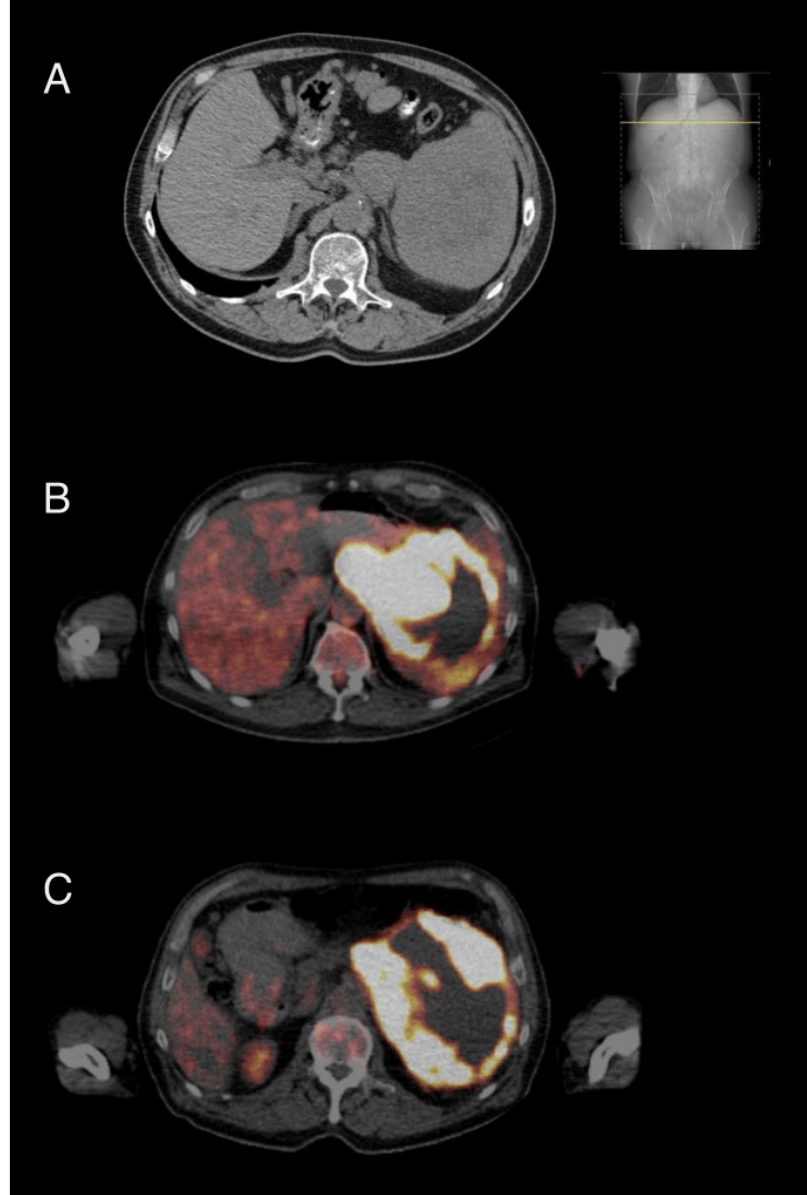
Figure 2. Clinical imaging of patient. ( A ) CT scan on 27 September 2017. Detection of DLBCL relapse with lymphoma manifestations around the splenic hilum. ( B ) PET-CT scan on 18 October 2017. Strong fluorodeoxyglucose metabolism in the area of the splenic hilum indicating active lymphatic tumor masses. ( C ) PET-CT scan on 18 January 2018. Regressive areas of glucose metabolism indicating regressive lymphatic tumor masses in the sense of a partial response.